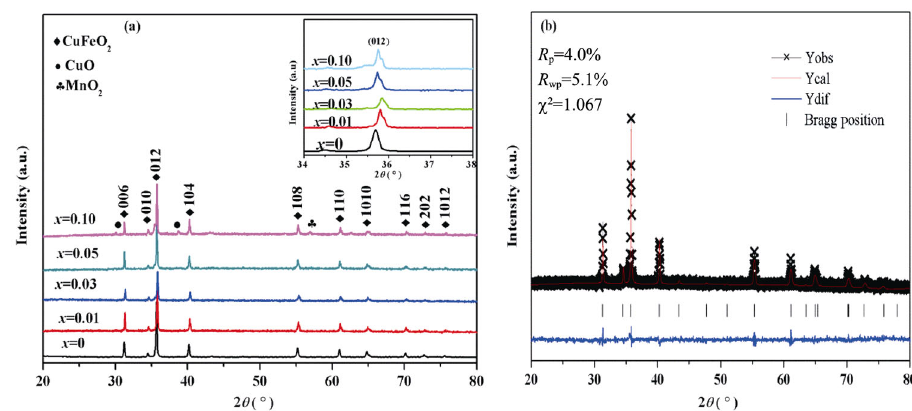
Fig. 1 (a) XRD patterns of the CuFe 1– x Mn x O 2 ( x = 0.00–0.10) samples. The inset illustrates the expansion of the main peak (012). (b) Rietveld analysis of CuFe 0.99 Mn 0.01 O 2 .